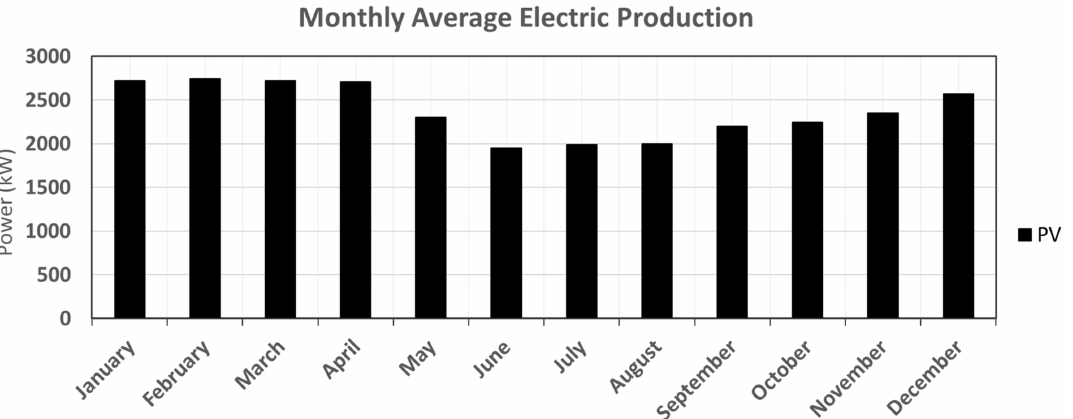
Figure 6. Summary of cash flow in the suggested configuration (created by the authors).